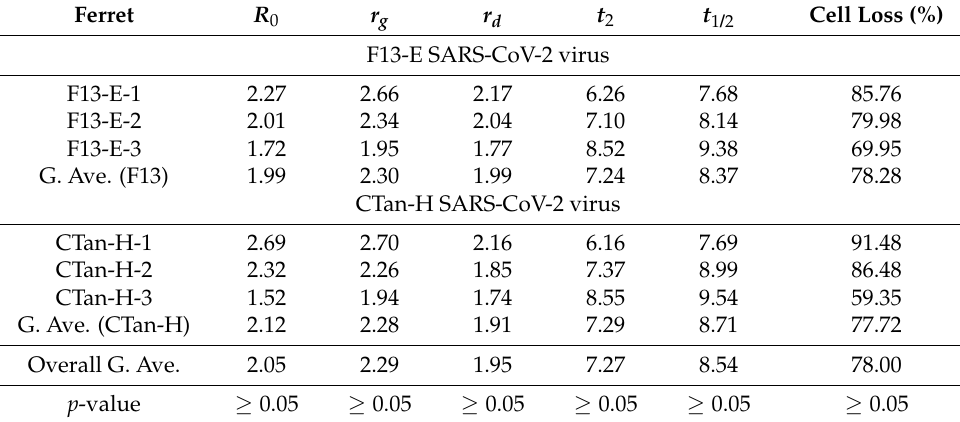
Table 4. Basic reproduction number ( R 0 ), pre-peak infectious viral growth rate ( r g ), post-peak infec- tious viral decay rate ( r d ), pre-peak infectious viral doubling time ( t 2 ), and post-peak infectious virus half-life ( t 1/2 ) for each ferret. The growth rate and decay rates are computed using the eigenvalues (cid:18) (cid:19) (cid:113) − ( c + δ ) + ( c + δ ) 2 + 4 c δ ( R t − 1 ) of the Jacobian: r = /2, where R t is approximation to the pre-peak and post-peak reproduction numbers. G. Ave. stands for geometric average. p -values indicate the result of comparison between F13-E and CTan-H groups.